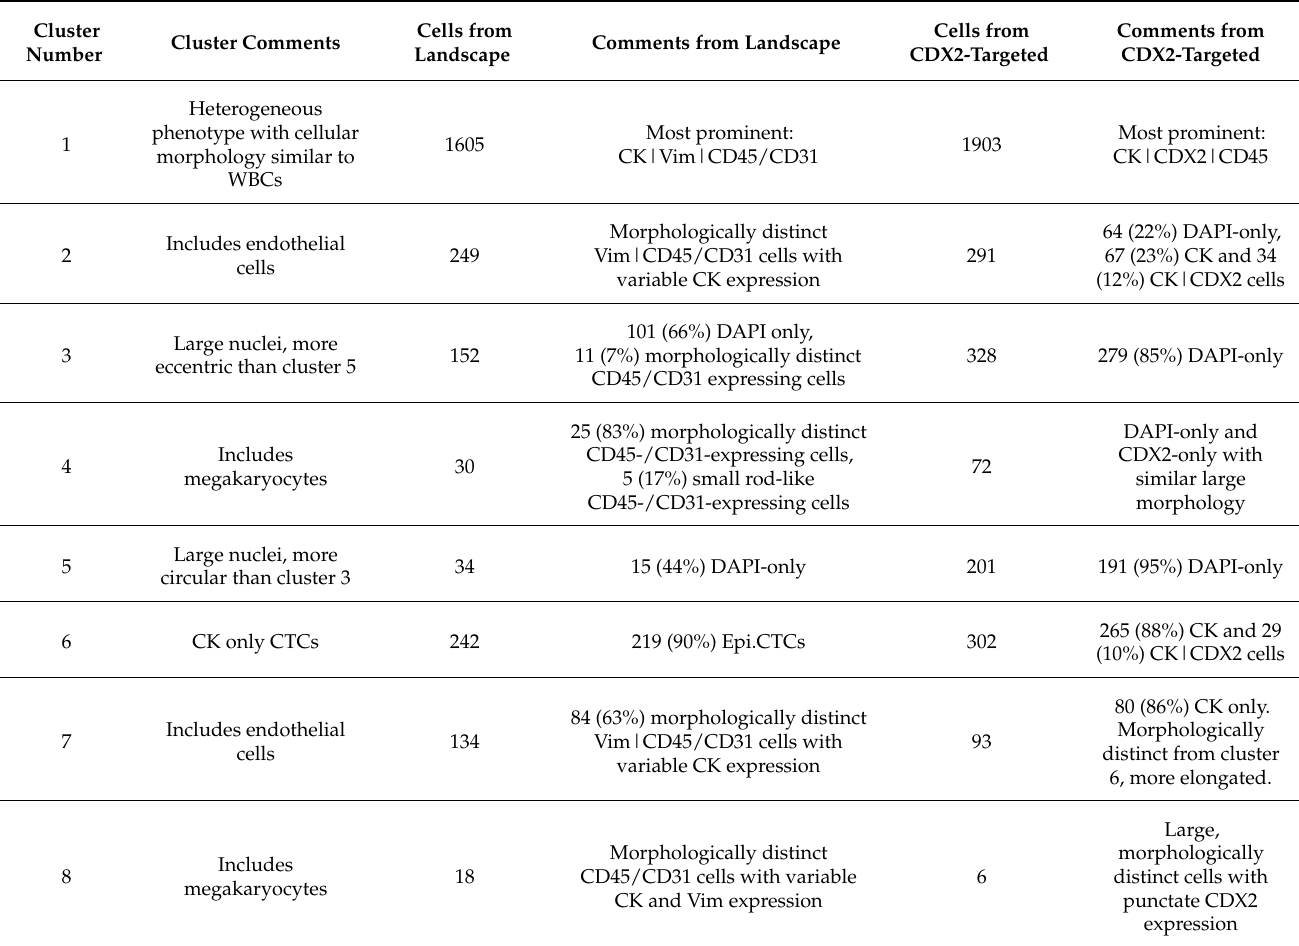
Table 2. Cellular description for the multi-assay cluster analysis. Cluster occupancy of the rare cells identified by the CDX2-targeted and Landscape staining protocols when using the 8-group hierarchical clustering model for multi-assay